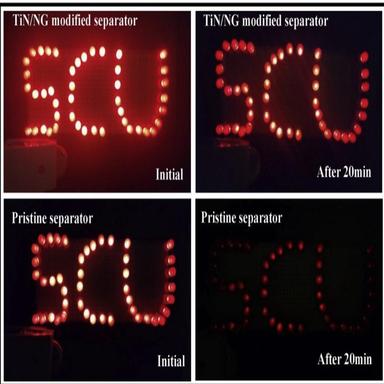
Digital photographs of LED modules powered by Li-S batteries with pristine separator and TiN/NG modified separator.